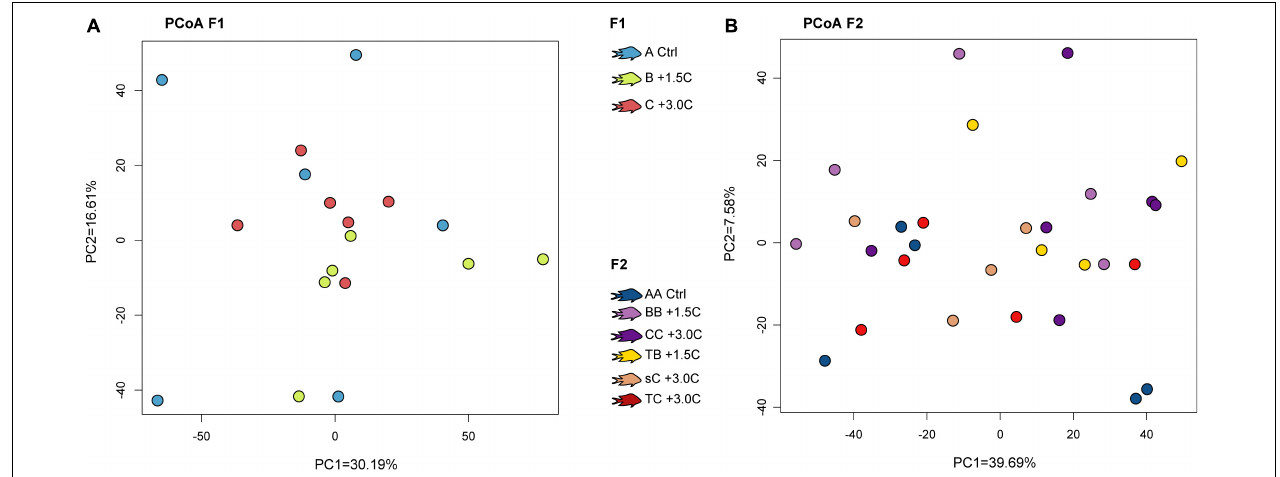
FIGURE 2 | Principal coordinate analysis based on the variance stabilized read counts of the differentially expressed genes by temperature, for the F1 (A) and F2 (B) . Colors represent the different thermal treatments. Control treatments are represented by the letter A, +1.5 ◦ C are represented by B, and +3.0 ◦ C are represented by the letter C. “TB” (+1.5 ◦ C) and “TC” (+3.0 ◦ C) represent transgenerational treatments of the F2, and “sC” represents the stepwise warming treatment (+1.5 ◦ C in F1 and +3.0 ◦ C in